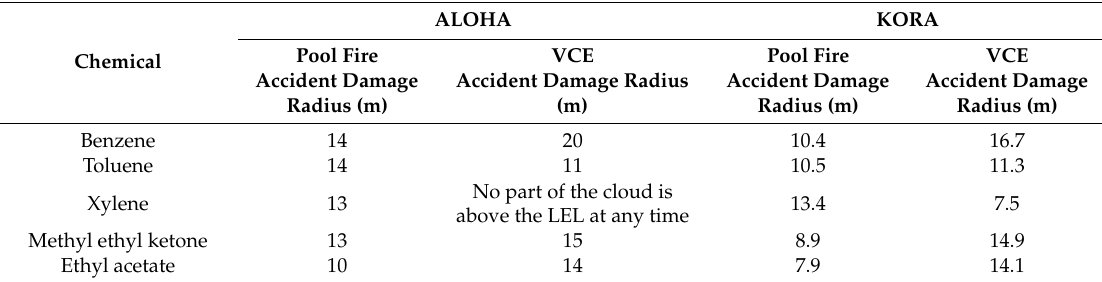
Table 6. Comparison of damage radius by modeling